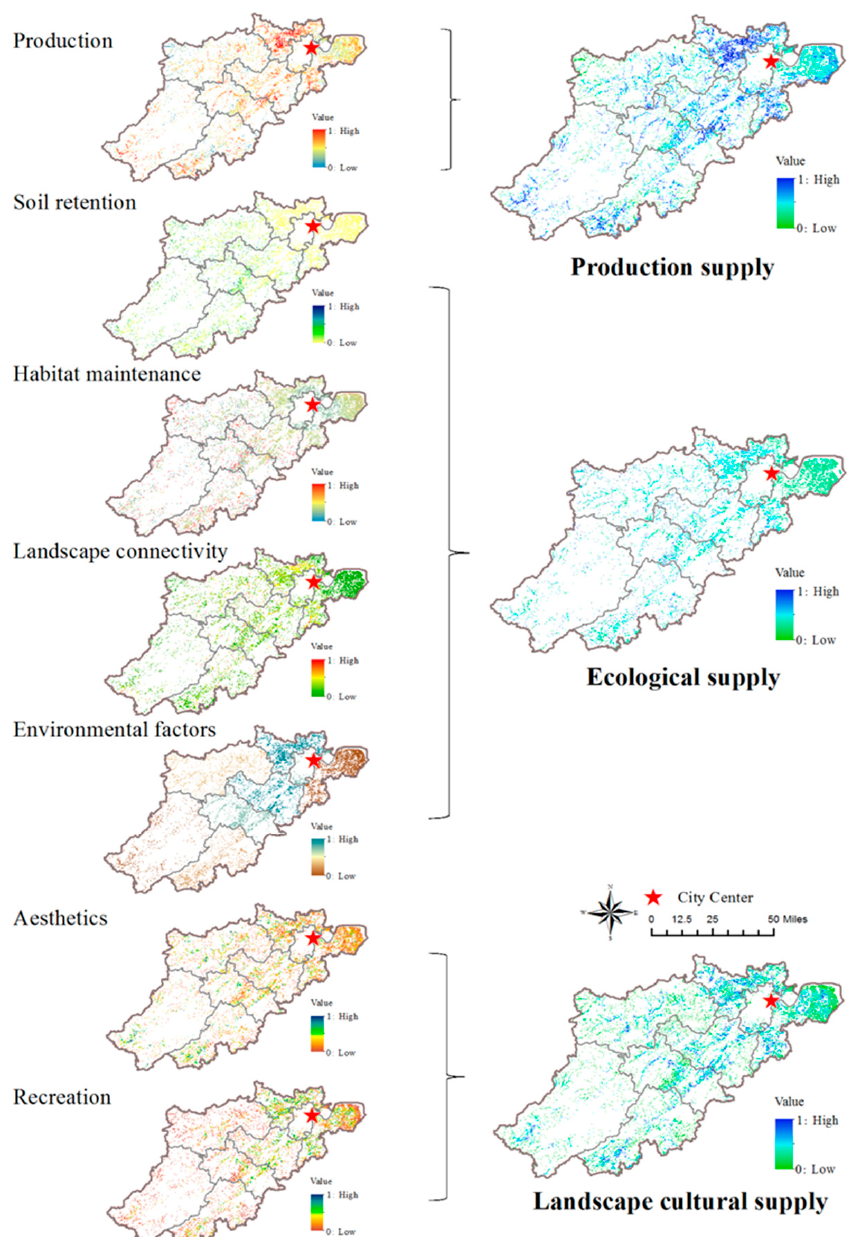
Figure 3. Supply patterns for seven sub-functions ( left ) and three functions ( right ) of farmland.